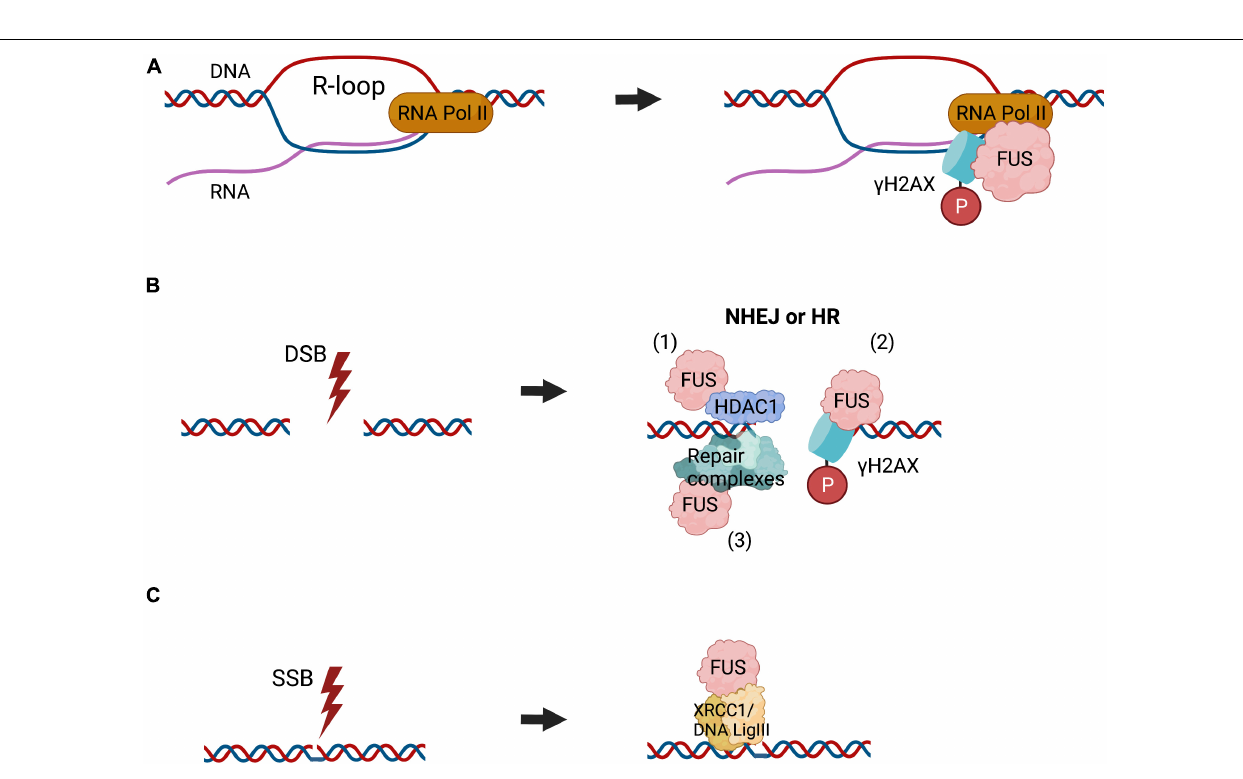
Frontiers in Aging Neuroscience |